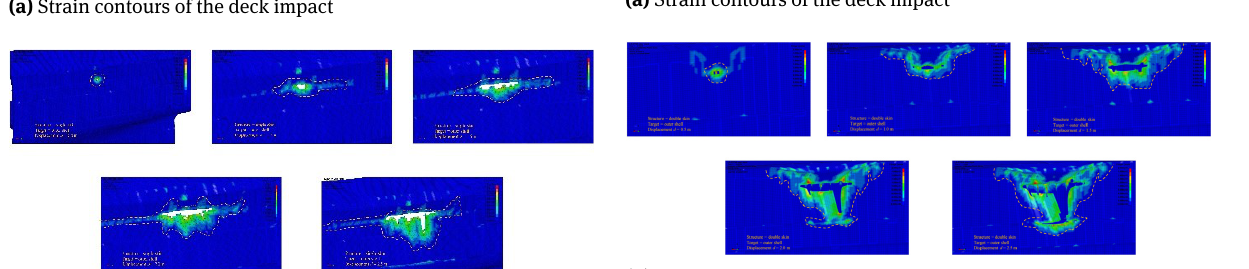
Figure 7: Summary of progressive failure on the SSS